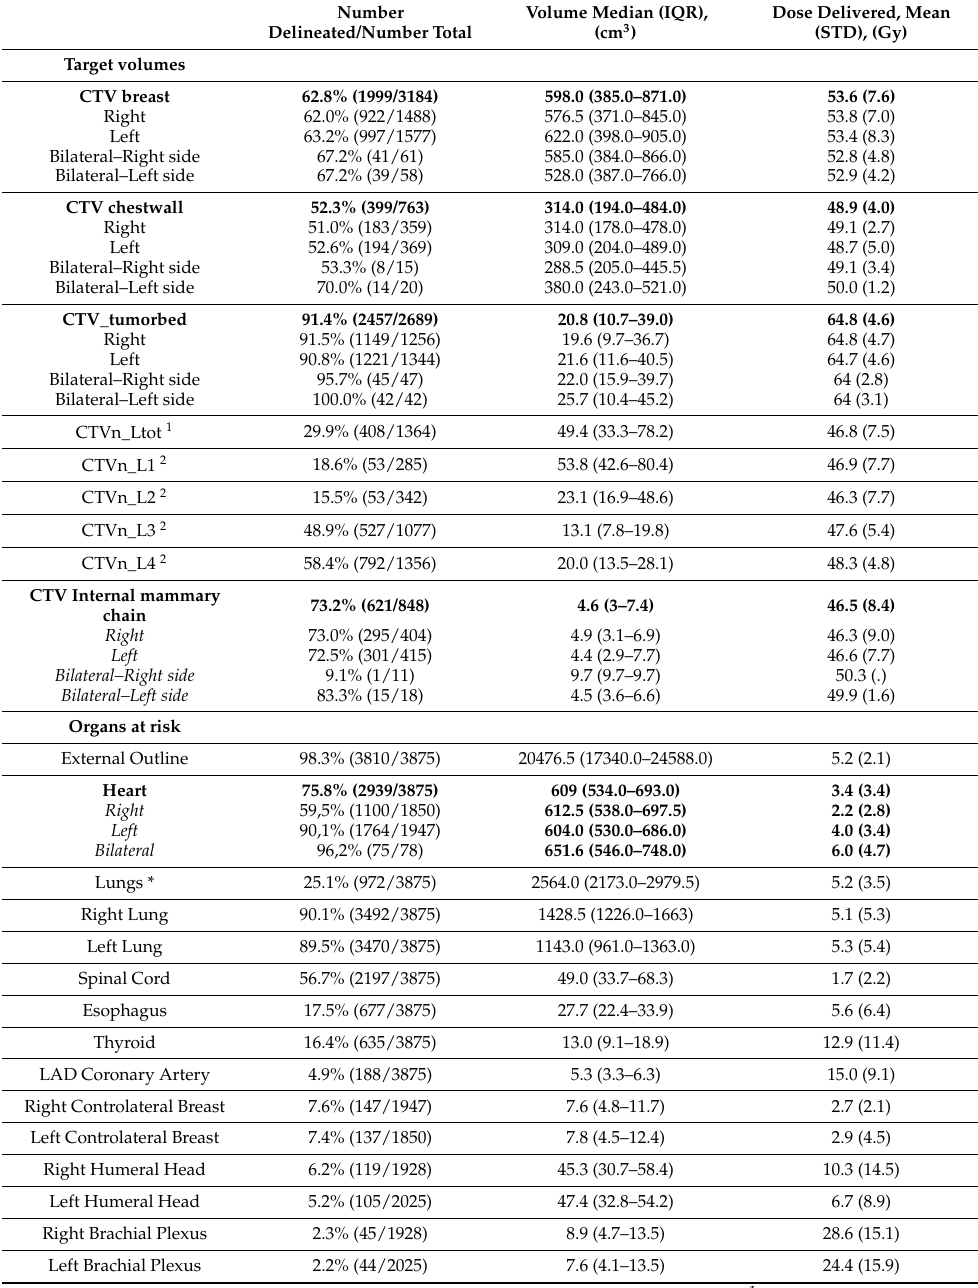
in 25 fractions in five weeks +/ − boost on the tumor bed of 16 Gy in 8 fractions). Moderate hypofractionationated RT was delivered in 166 (4.3%) patients with mostly 40 Gy in 15 fractions of 2.67 Gy in three weeks. More severe hypofractionation (accelerated partial unspecified fractionation rate was 24.5% because of missing contours for CTV breast or chestwall (Table 3). Table 3. Radiotherapy data available in